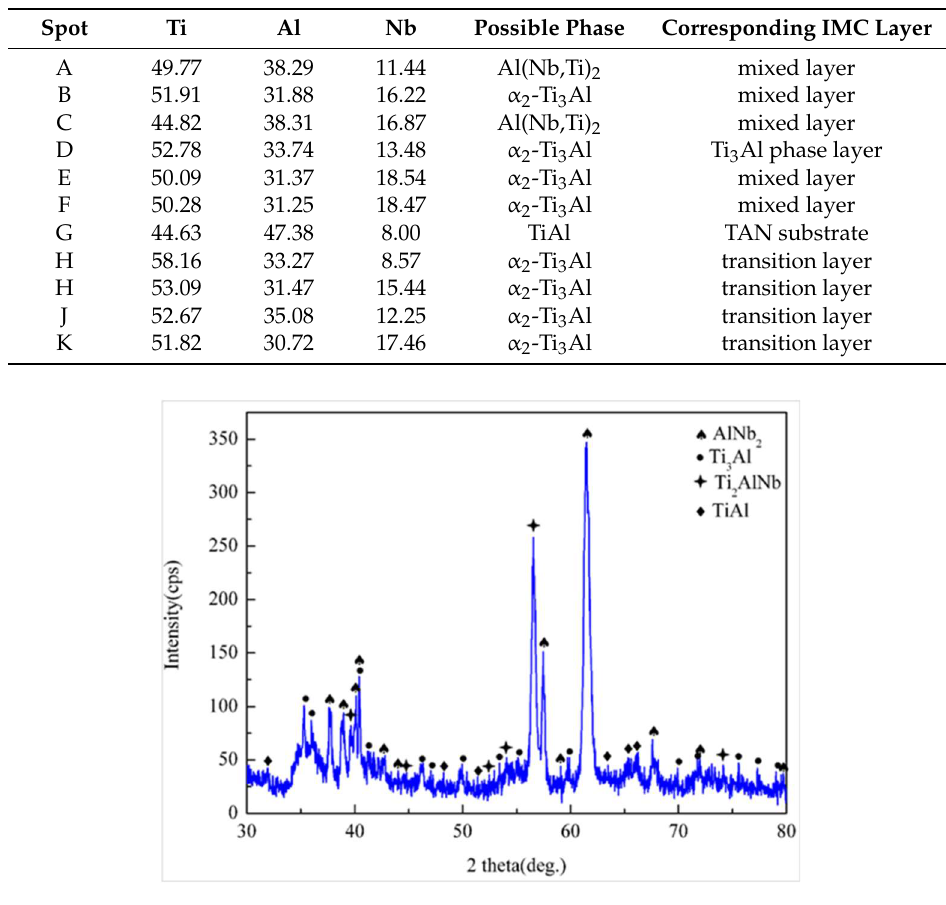
Figure 8. XRD patterns of the fracture surface after shear test of the joints bonded at 970 °C /60 min/5 MPa. For the joints created at 930 °C for 60 min, plenty of pores existed in the joints, decreasing the real bond area. Shear strength was therefore poor. As the bonding temperature increased, a compact contact was guaranteed and sufficient reactions occurred, following the interdiffusion of atoms.